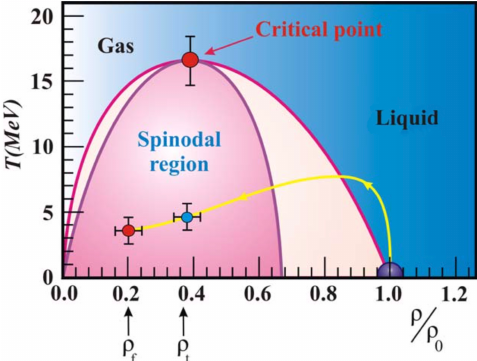
Figure 16. Experimental data and analysis of fragmentation in p ( 8.1 GeV )+ Au collisions, and proposed spinodal region for the nuclear system [87]. The arrow line shows the path of the system from the starting point at T = 0 and ρ 0 to the multi-scission point at ρ f . The points for the partition and freeze-out configurations are located at ρ t and ρ f